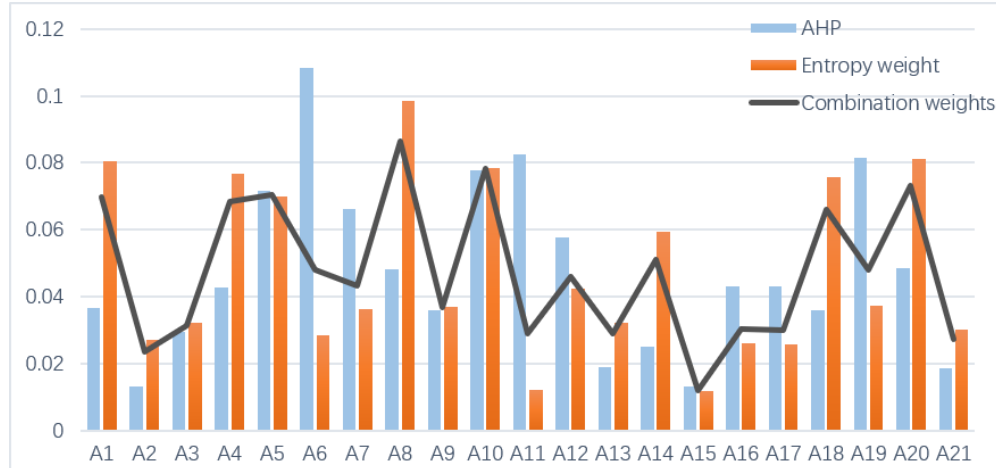
Figure 2. The subjective and objective index